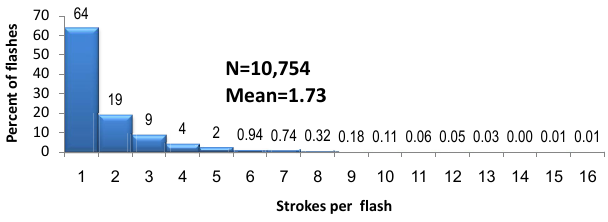
Fig. 1. The multiplicity distribution in thunderstorms in the study